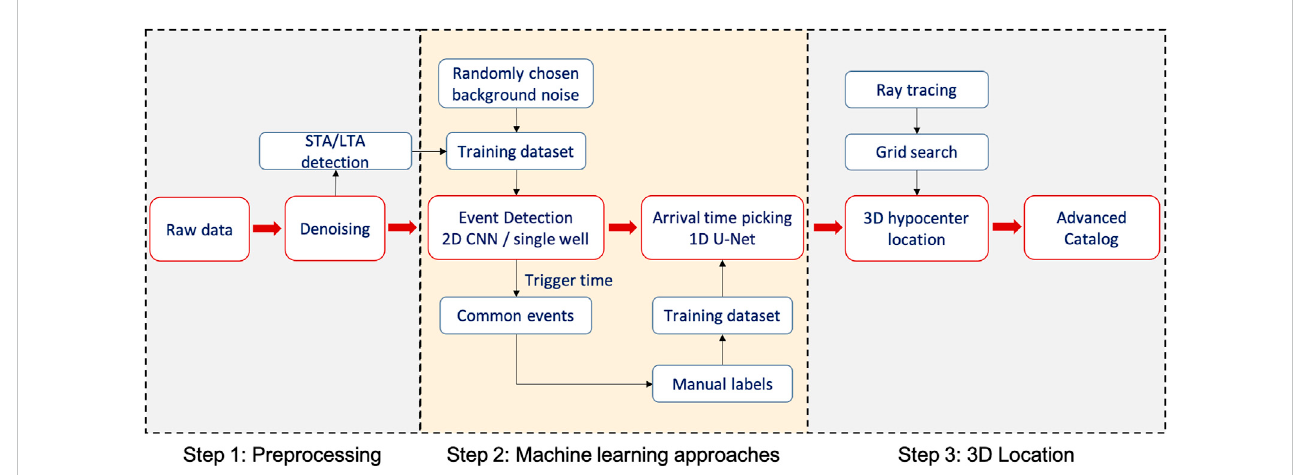
FIGURE 1 Machine learning-assisted processing work fl ow for multi- fi ber DAS microseismic data developed in this project. The primary work fl ow is highlighted in red. The machine learning algorithms developed here occur in Step